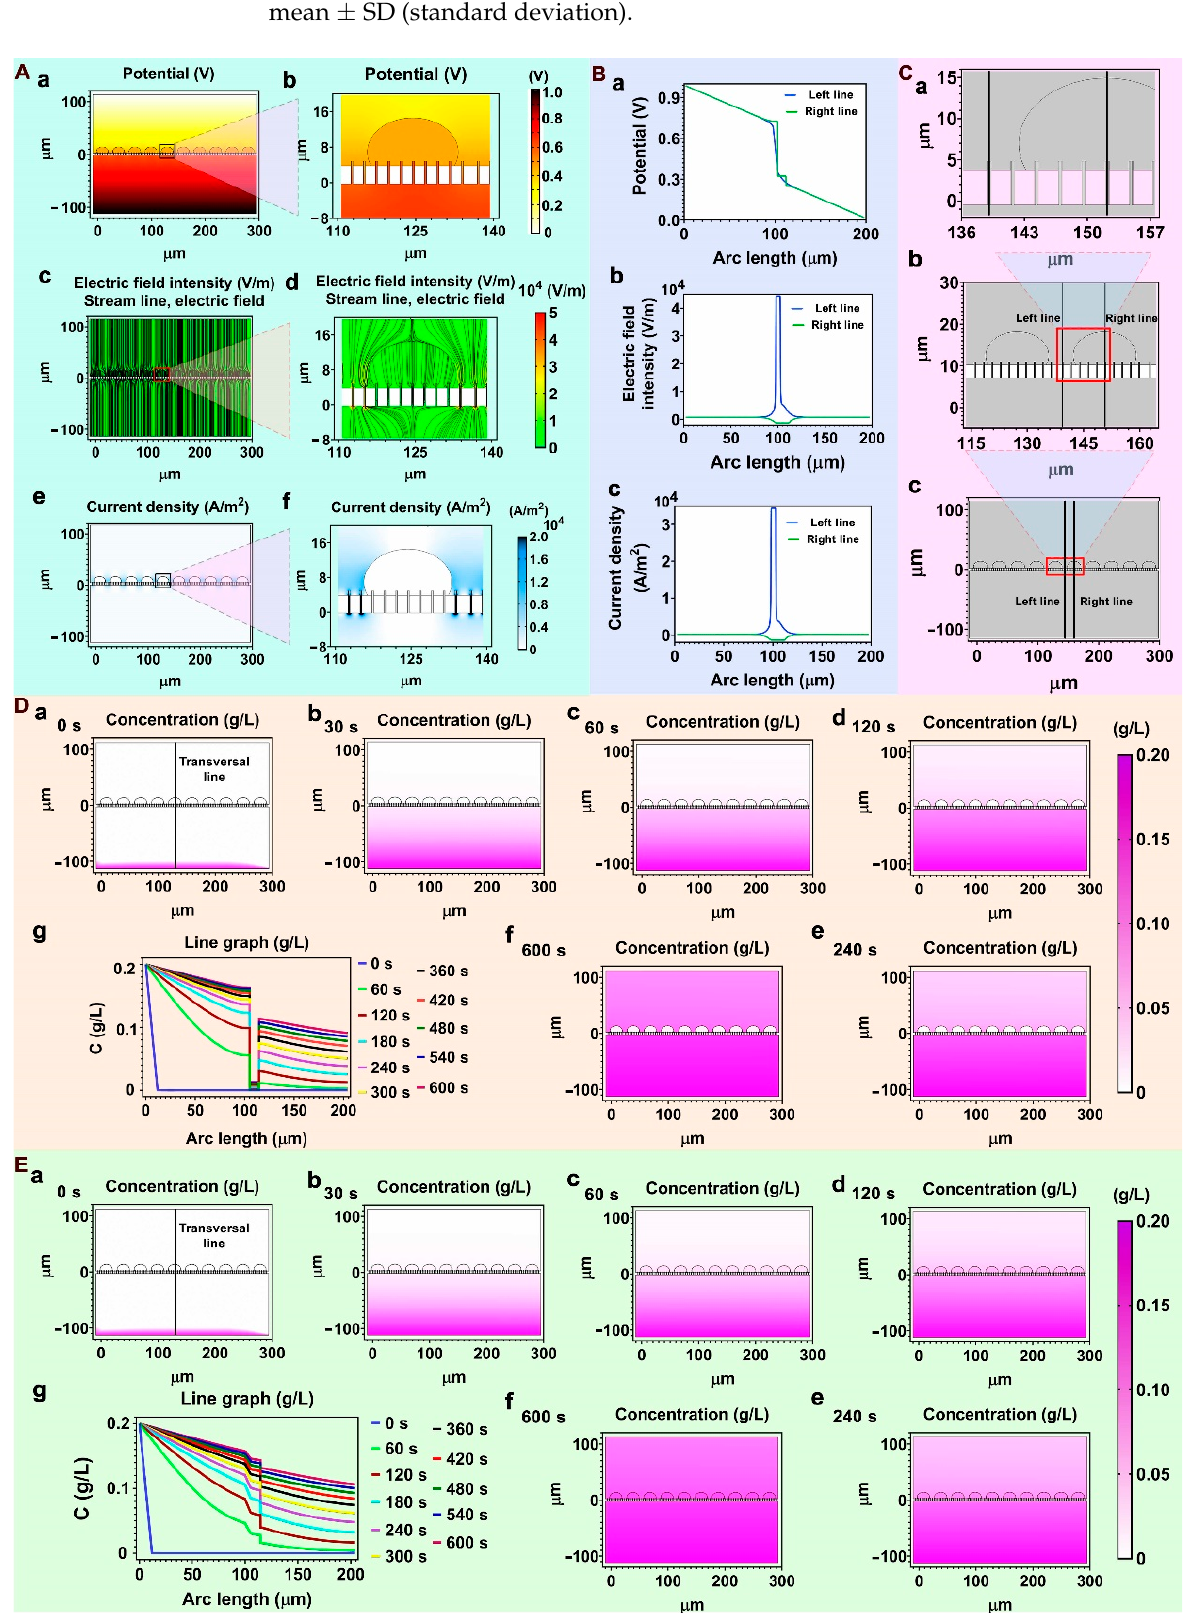
Figure 2. COMSOL simulation of nanostraw electroporation. ( A ), Profiles of the distribution of V, E, J and electric field stream line ( A-a – A-f ). The ( A-b , A-d , A-f ) were the local magnification of ( A- a , A-c , A-e ), respectively. ( B ), the value curves of V, E, J ( B-a – B-c ) on the vertical transversal lines in figure ( C ) ( X -axis was the distance from the bottom electrode, Y -axis was the value of V, E and J). ( C ), the geometric graph of nanostraw-electroporation simulation model ( C-c ) and its partial en- larged graph ( C-a , C-b ), the left vertical line crossed the interior of nanostraw, the right vertical line crossed the interior of the nanostraw and the cell upside. ( D ), the drug molecules diffusion in nanos- traw-array system within 600 s ( D-a – D-f ) before nanostraw-electroporation, a transversal line ( D- a ) crossed the nanosraw and the cell. ( D-g ), the diffusion concentration curve within 600 s on the transversal line ( a ) before cell perforation (time interval, 60 s). X -axis was the position on the trans- versal line, Y -axis was the concentration of drug molecules on the transversal line. ( E ), the drug molecules diffusion in nanostraw-array system within 600 s ( E-a – E-f ) after cell perforation, a